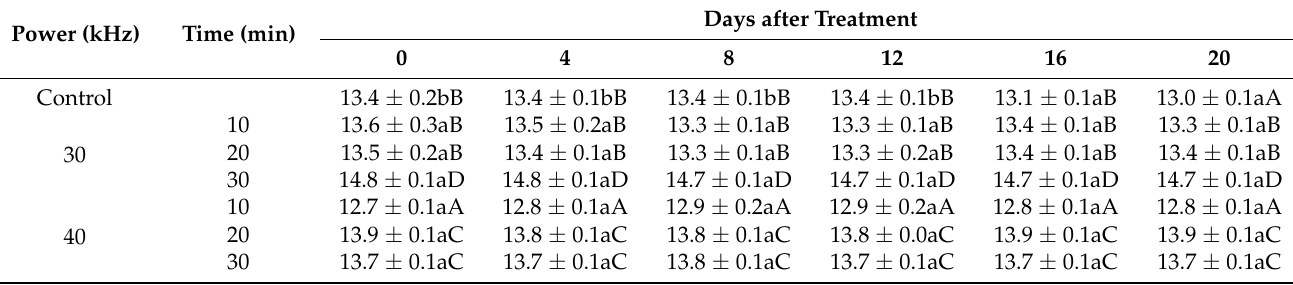
Data expressed as mean ± standard deviation of three repetitions. In the same row, different lowercase letters indicate statistically significant differences between treatment days ( p < 0.05). In the same column, different capital letters indicate statistically significant differences between the treatments ( p <